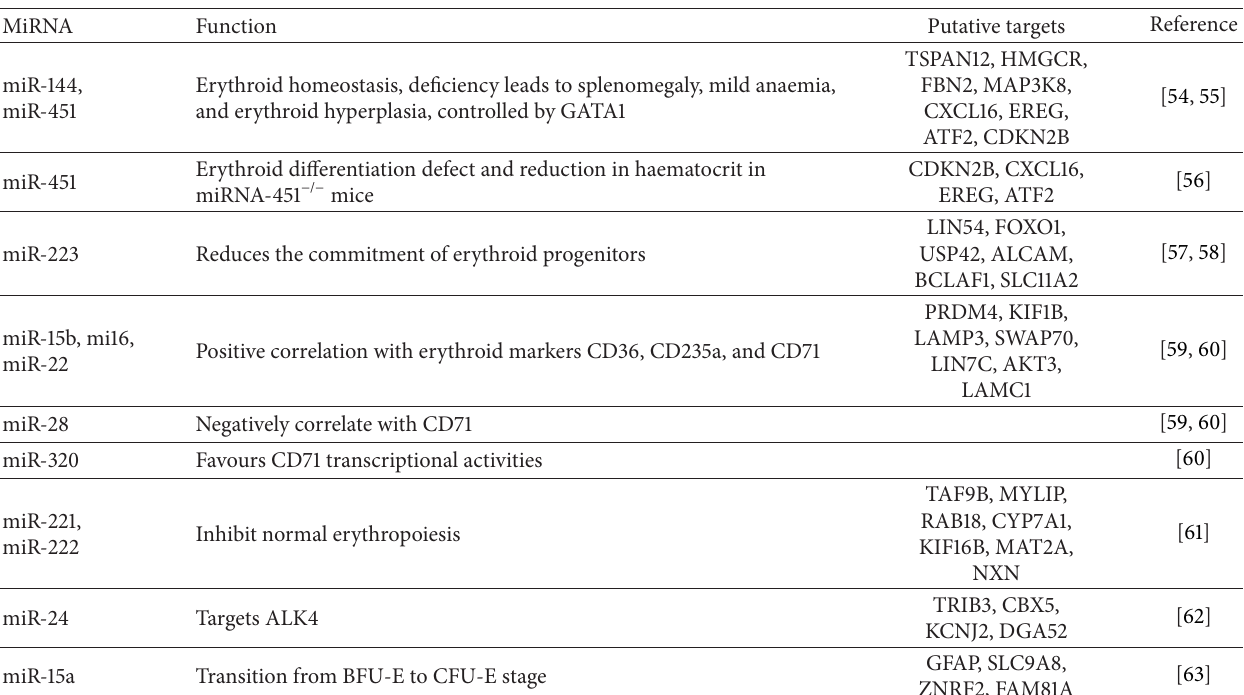
Table 5: miRNAs involved in